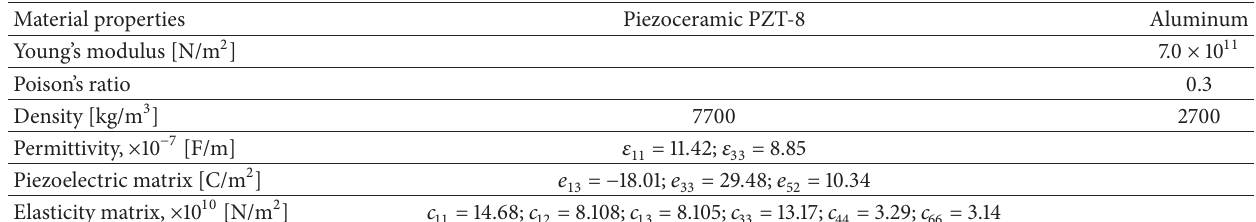
Table 1: Properties of the actuator materials.